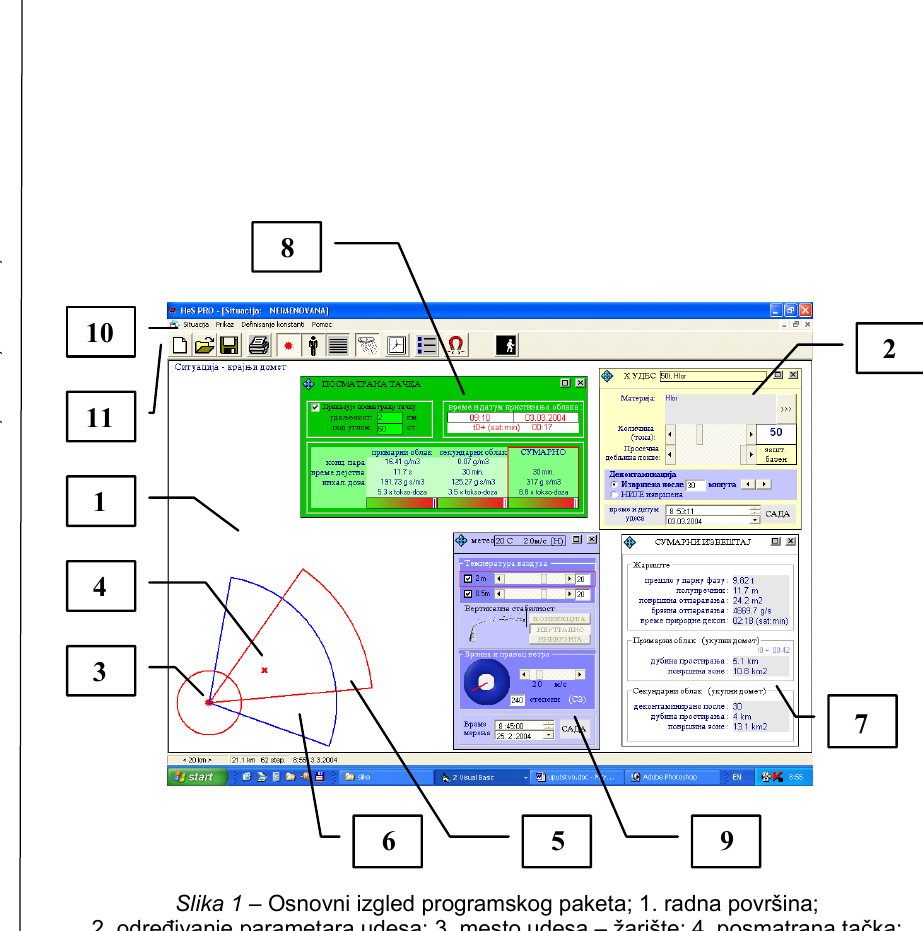
Figure 1 – The basic layout of the software package; 1. desktop; 2. parameters of accidents; 3. accident site - the focus; 4. observed point; 5. primary cloud zone and scope; 6. secondary cloud zone and scope; 7. summary report; 8. observed point data and the effect of the cloud on it; 9. data about weather conditions in the given area; 10. menu system; 11. space to run (turn on)